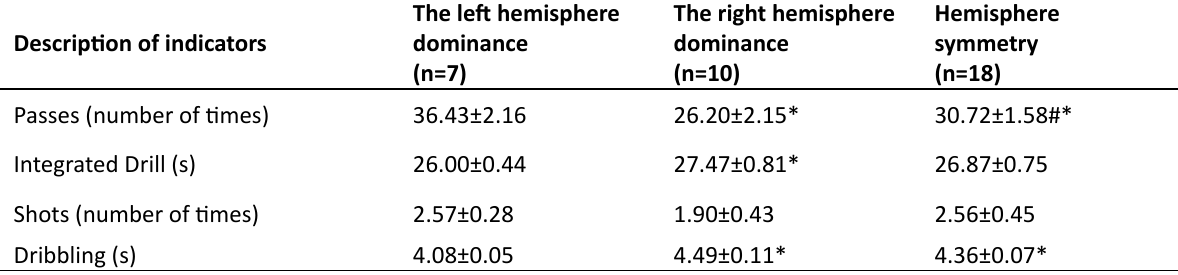
Table 2. Indicators of technical readiness of basketball players aged 12-13 with different cerebral asymmetry profile while exercising with the sub-dominant hand.